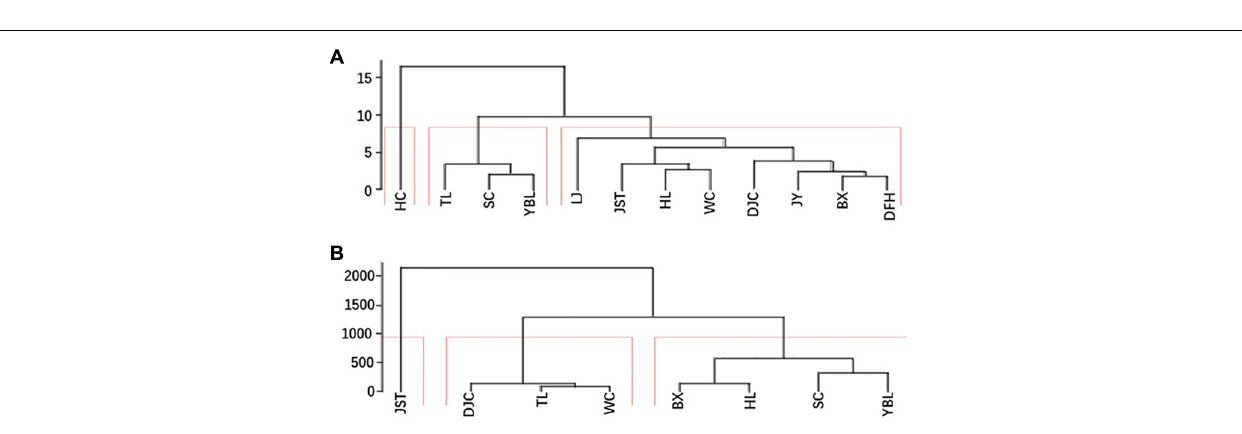
FIGURE 6 | Two clustering maps. For each site, the average of all individuals was sued for clustering. (A) Clustering using morphological data. (B) Clustering using kernel nutritional compositions. BX, Binxian, HLJ; DJC, Ning’an, HLJ; HL, Hulin, HLJ; JST, Yichun, HLJ; SC, Baishan, JL; TL, Tieli, HLJ; WC, Wuchang, HLJ;YBL, Yabuli, HLJ. HLJ,